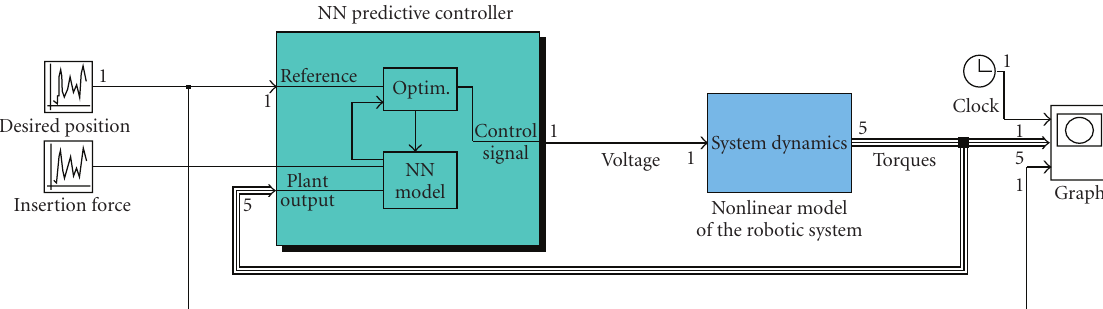
Figure 5: Predictive control system scheme: Neural network model is used to predict future plant performances. The controller calculates the control input that optimizes robotic system performances. After system identification procedure, robot model is used to predict future